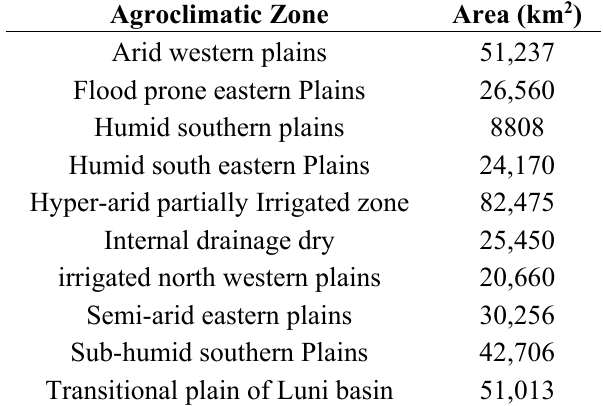
Table 1. Agroclimatic Zone area in